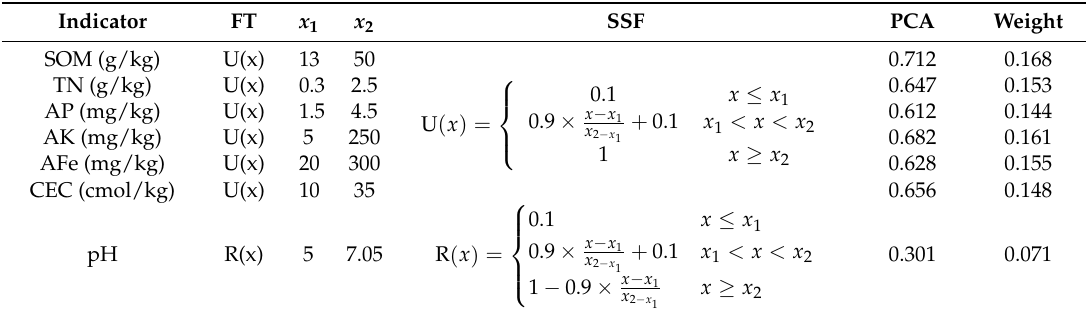
Table 3. The standard scoring function (SSF) method and the weights of